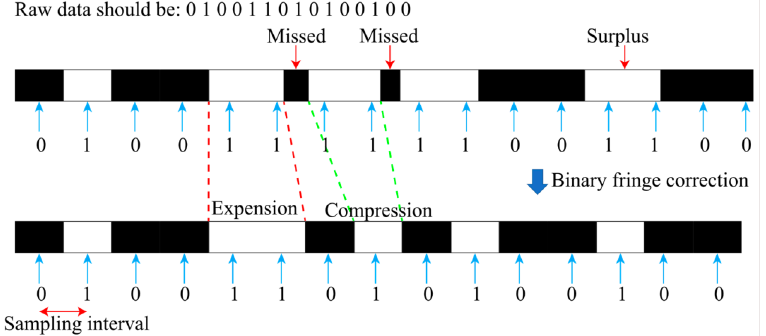
Figure 2. Schematic diagram of sampling offset and the binary fringes correction (BFC)